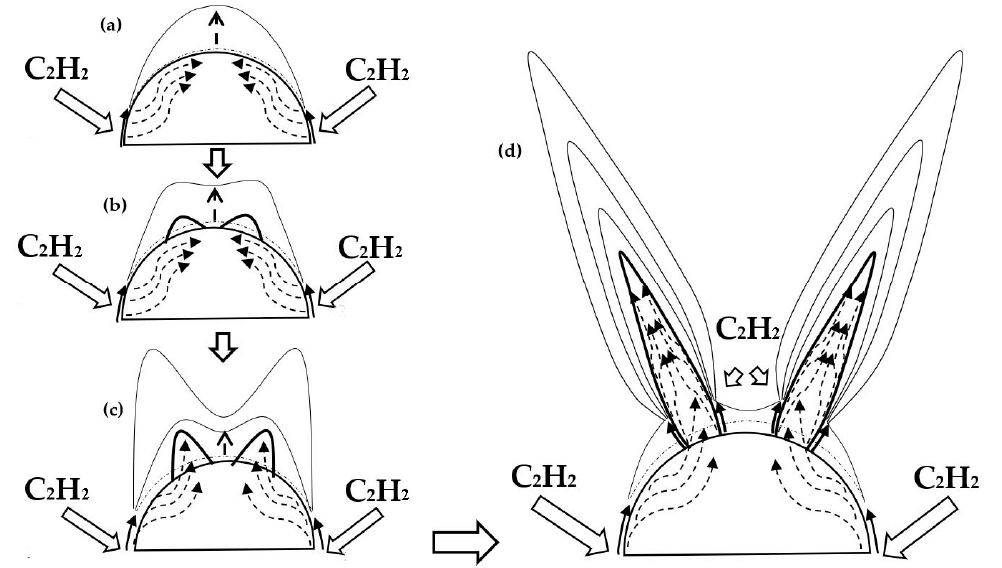
Figure 4. The proposed mechanism of the reed-leaf-like carbon nanostructure (CNL).